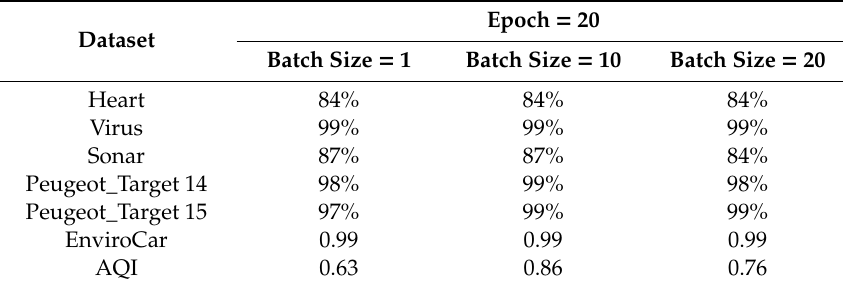
Table 32. Performance on di ff erence batch size.